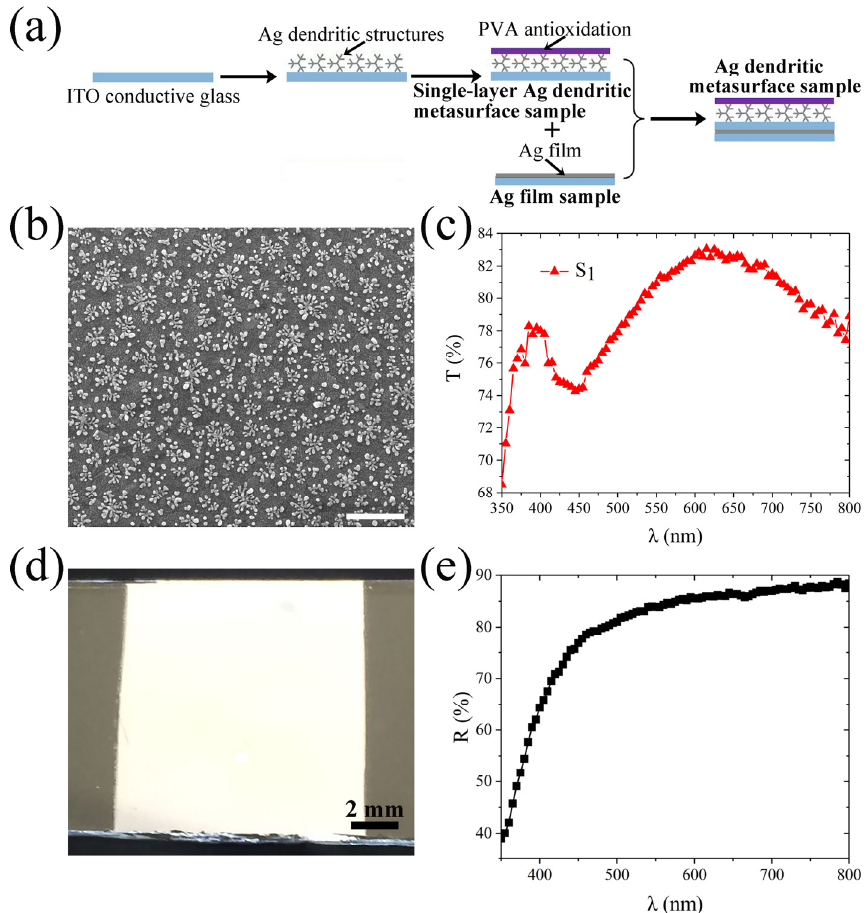
Figure 4. Ag dendritic metasurface sample. ( a ) Schematic of the assembly process of Ag dendritic metasurface sample. ( b ) SEM image of the prepared single-layer Ag dendritic metasurface sample without the polyvinyl alcohol (PVA) coating. Scale bar: 500 nm. ( c ) Transmission spectrum of the